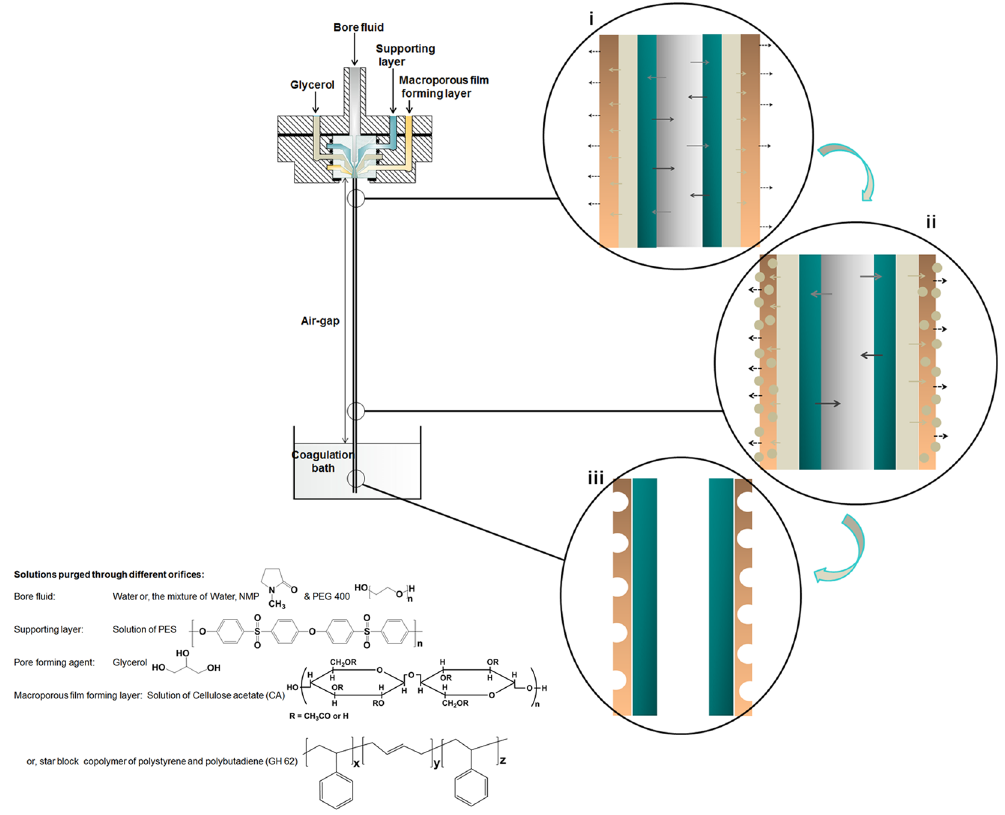
Figure 1. Left part of the picture shows the dry-jet wet spinning method for hollow fiber production mentioning the chemical structures of the materials purged through the different orifices of the spinneret. Right part of the picture depicts the mass transfer phenomena in the hollow fiber; i Solvent and non-solvent exchange between bore fluid and the support layer solution, evaporation of the volatile solvent from the porous film forming layer and meanwhile glycerol diffusion in to the porous film forming layer. ii Solvent and non-solvent exchange between bore fluid and supporting layer solution continues, glycerol gets saturated in the solvent of the film forming solution and forms droplets which condense out afterwards. iii Porous film formed in hollow fiber geometry with support layer underneath. Since different polymers are used for preparing supporting layer solution and the porous film forming layer solution, these two layers typically delaminate from each